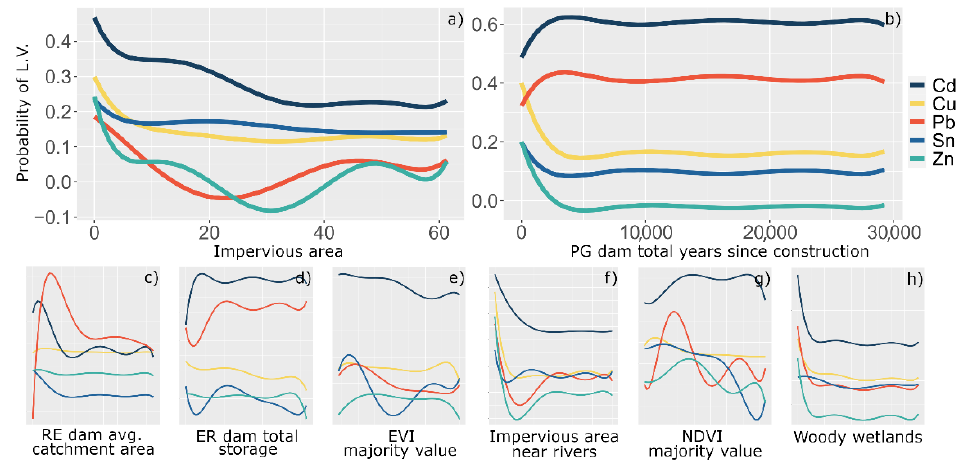
Figure 6. PDP plots for group C3. The x -axis represents a MIV, the y -axis represents the associated probability of a L.V. (lower value) classification. Each line represents the relationship for a single metal. The plots show: ( a ) Impervious area (percentage of impervious surface area in 2001), ( b ) PG dam total years since construction (sum of the years since construction for all dams of type Gravity), ( c ) RE dam average catchment area (average area contributing to dams of type Earth), ( d ) ER dam total storage (total storage of all dams of type Rockfill), ( e ) EVI majority value (most common EVI value), ( f ) Impervious area near rivers (percentage of impervious surfaces in a buffer 100 m around rivers), ( g ) NDVI majority value (most common NDVI value) and ( h ) Woody wetlands. “ EVI ” = Enhanced Vegetation Index, “ NDVI ” = Normalized Difference Vegetation Index. Lines are dis- played after smoothing with a polynomial regression for display purposes.